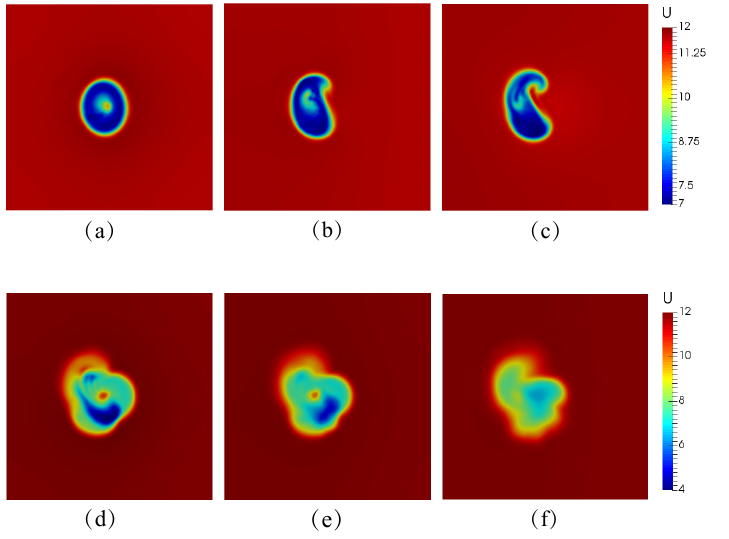
Figure 12. Contours of time-averaged velocity in the vertical plane at hub height: ( a ) 1D downstream of WT1; ( b ) 4D downstream of WT1; ( c ) 6D downstream of WT1; ( d ) 1D downstream of WT2; ( e ) 2D downstream of WT2; ( f ) 4D downstream of